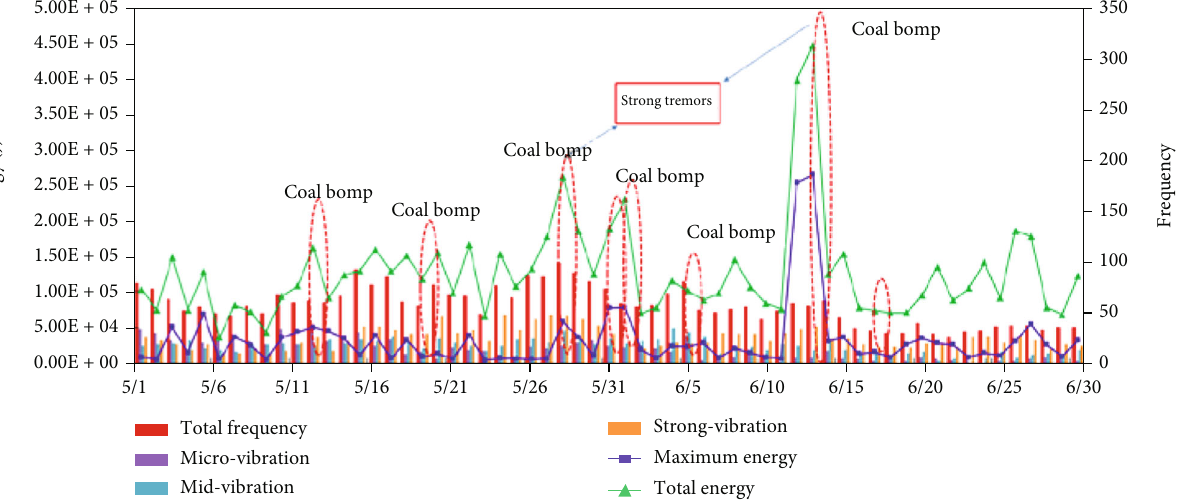
Figure 14: Time series of the tremors before the occurrence of rock bursts.